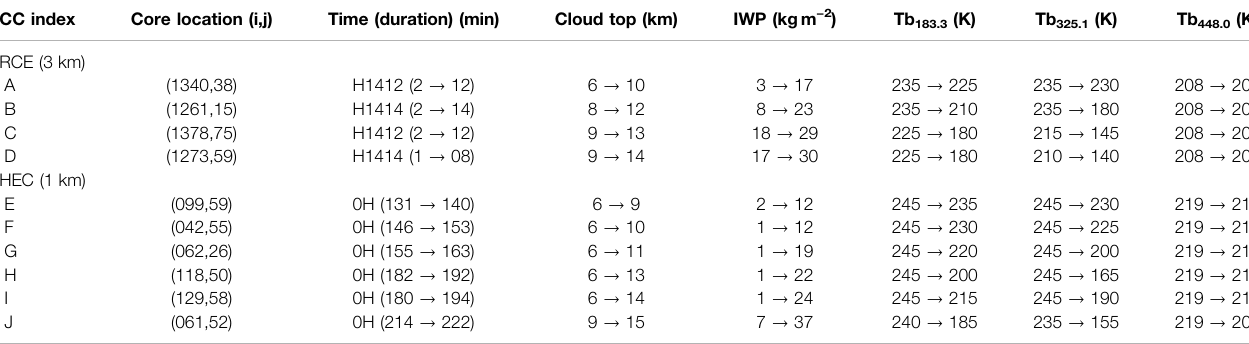
TABLE 1 | Overview of the convective cells in the growing phase selected in RCE and